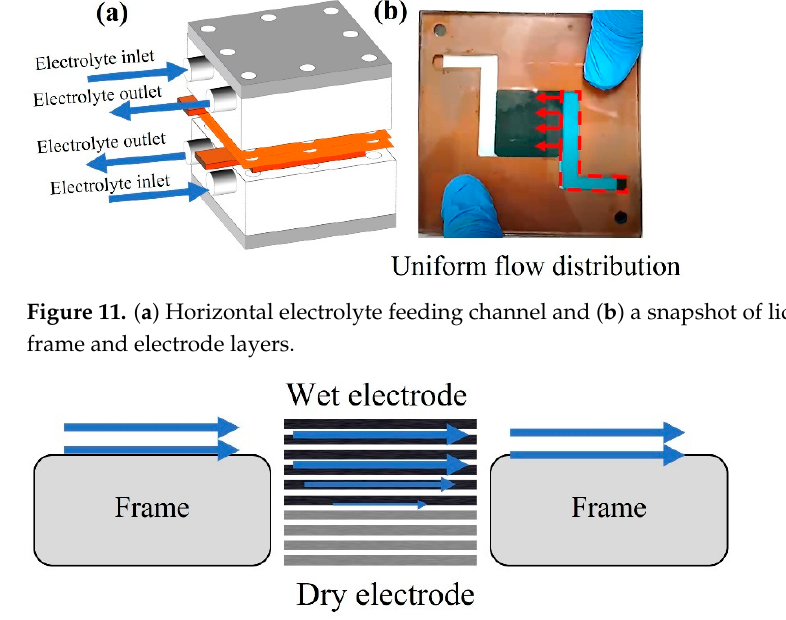
Figure 11. ( a ) Horizontal electrolyte feeding channel and ( b ) a snapshot of liquid flow into the flow frame and electrode layers.